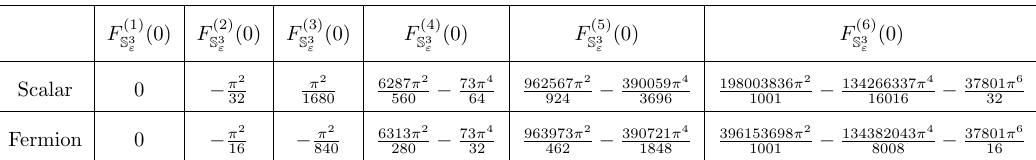
Table 1 . Values of derivatives of F S 3 with respect to the squashing parameter " evaluated at " = 0 " for a conformally-coupled scalar and a free